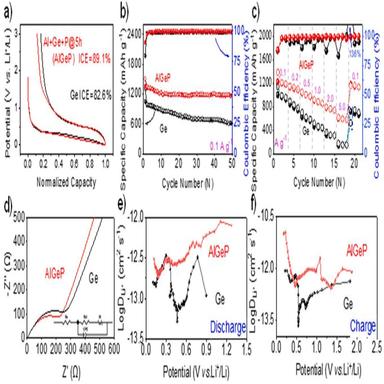
(a) Initial discharge/charge profiles of AlGeP solid solution and milled Ge electrodes. (b) Cycling stabilities of AlGeP solid solution and milled Ge electrodes. (c) Rate performances of AlGeP solid solution and milled Ge electrodes. (d) EIS spectra of AlGeP solid solution and milled Ge electrodes. Diffusion coefficients of Li ions as function of voltage as determined by GITT during discharging and (f) charging processes.